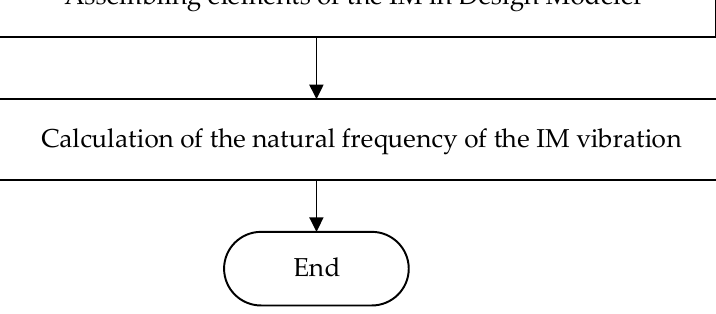
Figure 1. A diagram of the information flow of the design of the IM. The initial aspect pertained to the stator housing’s design, encompassing cooling ribs, feet, and boron, ultimately serving as the terminal box. Figure 2 shows a diagram of the information flow when designing an asynchronous motor.